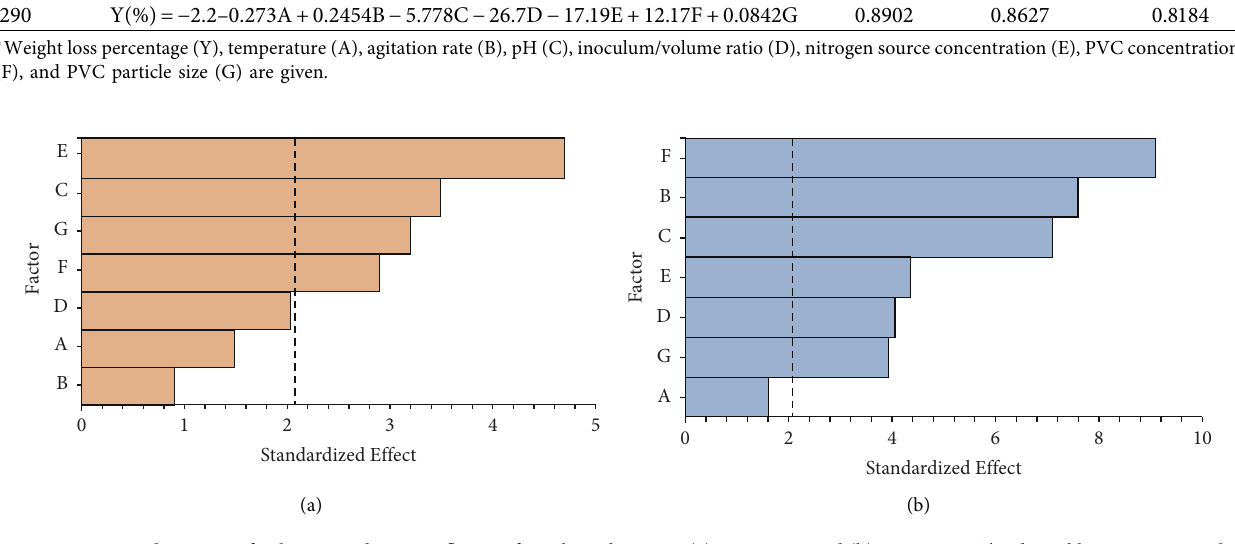
Figure 6: PVC weight loss percentage by each strain on Plackett − Burman design trials. All the values are presented as the mean ± error of data from experiments performed as triplicates. Bars indicate the standard deviation of data. Arrows show the trial with higher PVC weight loss by each selected strain, trial 10 for strain 208 (orange) and trial 11 for strain 290 (blue). Control used was PVC resin on culture media (MSM) with no bacterial exposure. Table 5: Mathematical relation of culture conditions and PVC biodegradation capacity for each selected strain. Strain Regression equation + R 2 R 2 (adjust) 208